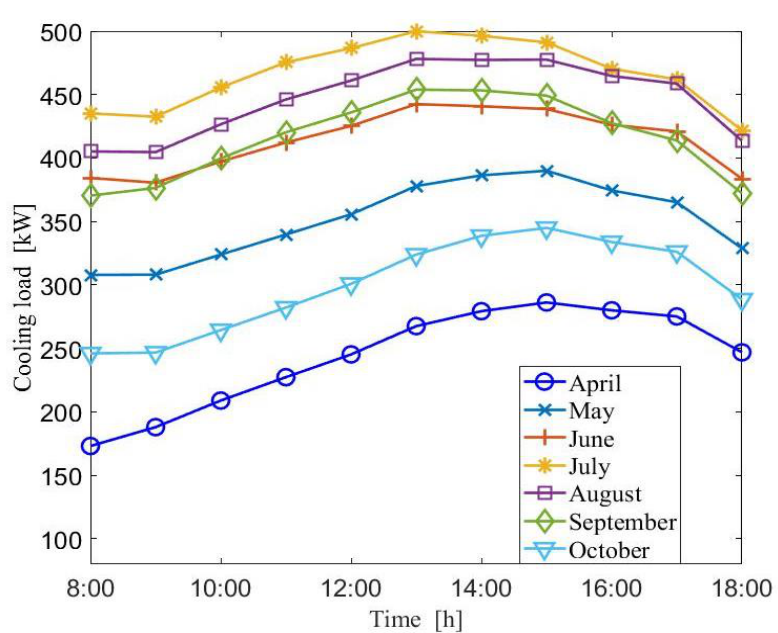
Figure 8. Cooling load.